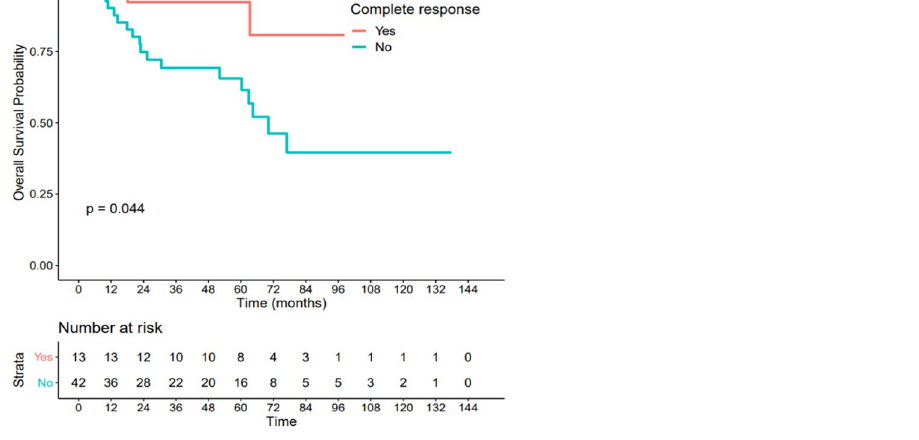
Figure 5. Association between pCR and overall survival. Patients with pCR had a significantly better overall survival (HR = 0.25 IC[0.06–1.08], p =